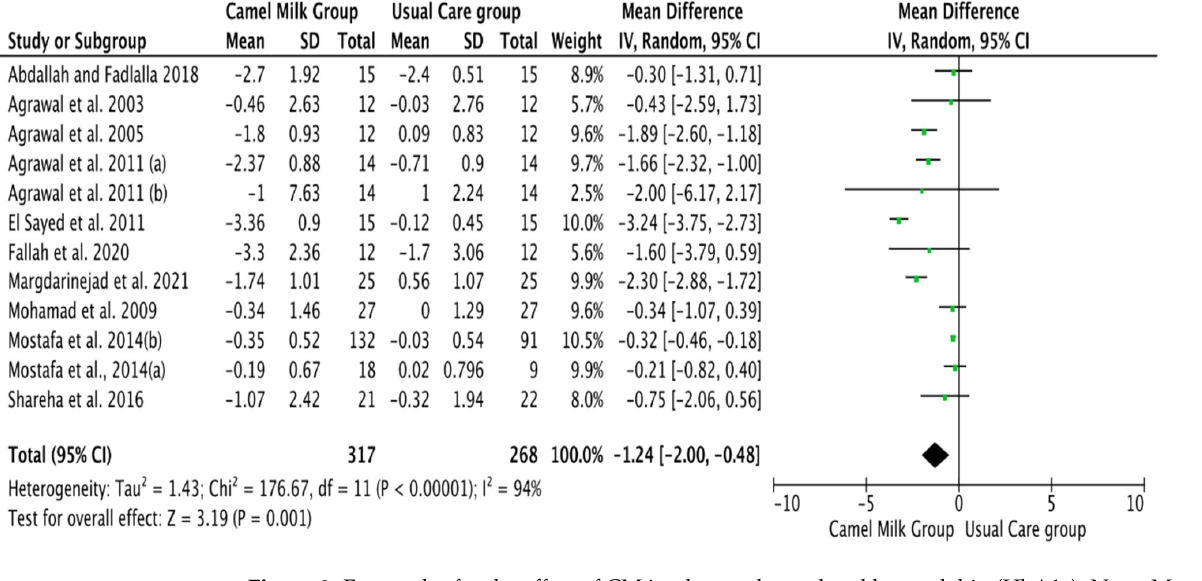
Figure 2. Forest plot for the effect of CM intake on glycosylated hemoglobin (HbA1c). Note: Mostafa and Al-Musa, 2014 (a) for T1DM and (b) for T2DM.